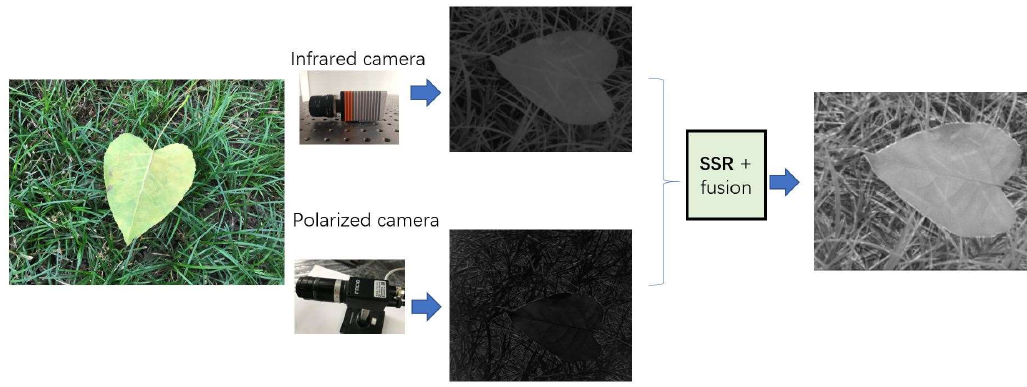
Figure 6. SSR application in real world imaging.